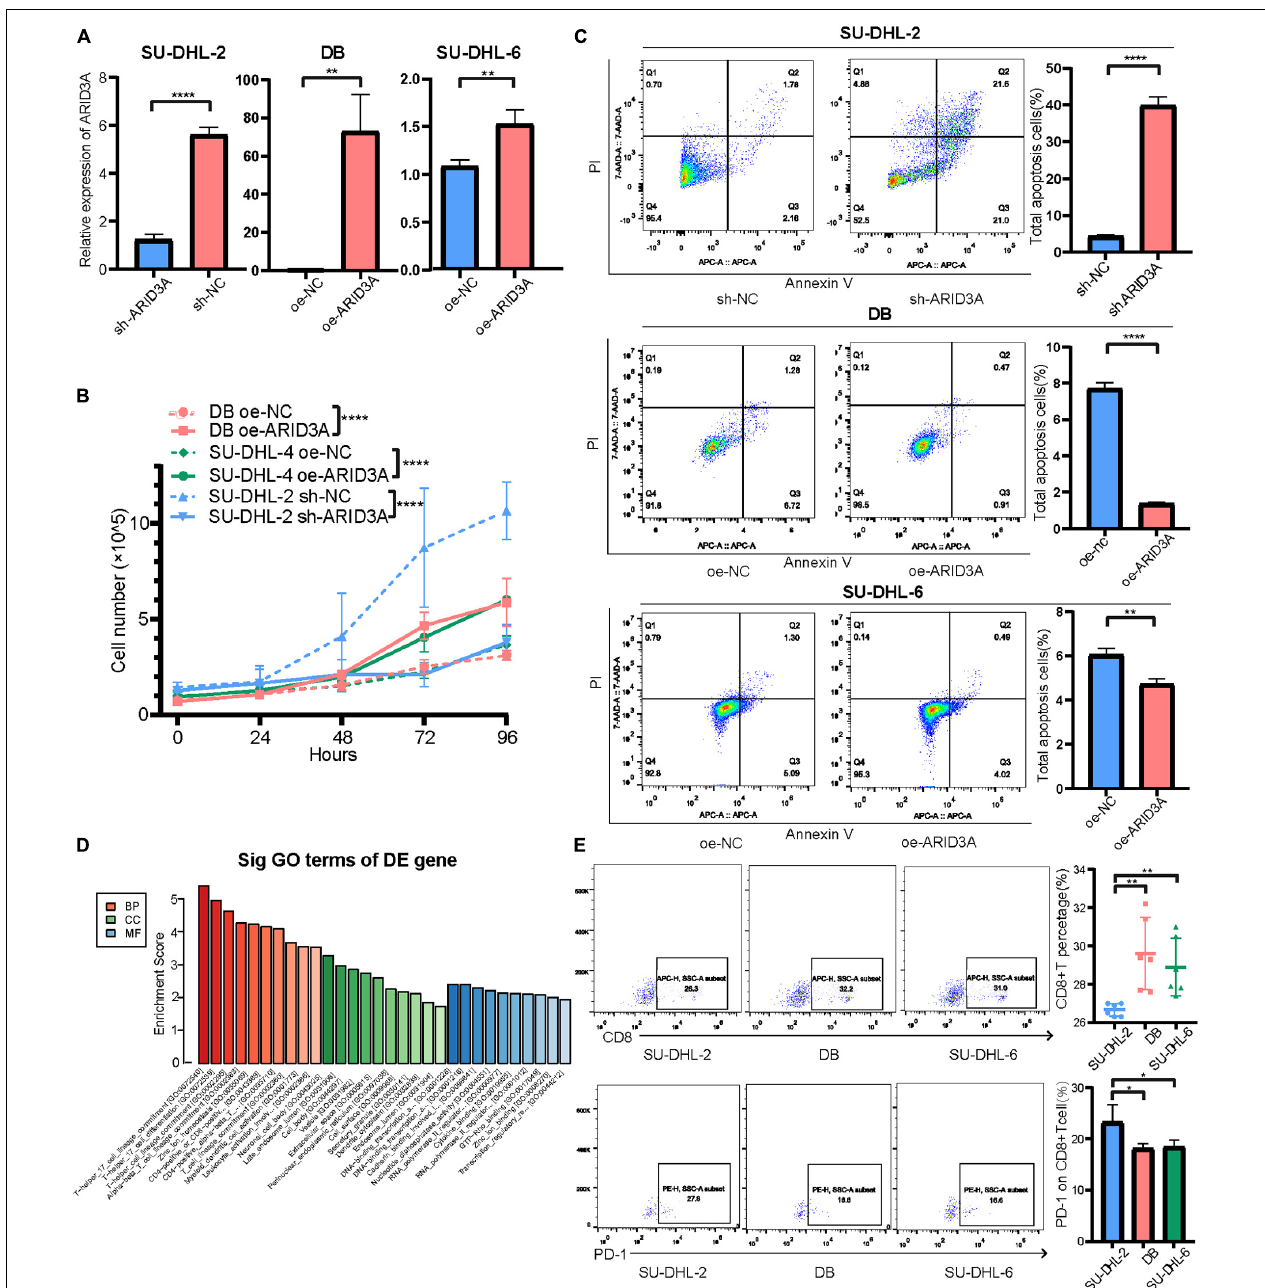
FIGURE 4 | (A) Inhibition and overexpression of ARID3A in DLBCL cells was confirmed with RT-qPCR assays. (B) Cell proliferation ability of ARID3A knockdown SU-DHL-2 cells, ARID3A overexpressing DB and SU-DHL6 cells, and negative control cells was counted using trypan blue exclusion staining. (C) Cell apoptosis assays showing the effect of ARID3A knockdown on SU-DHL-2 cells and ARID3A overexpression on DB and SU-DHL-6 cell apoptosis. (D) Differentially intersected genes were subjected to GO term enrichment analyses. (E) CD8 + T cell percentage and the surface PD-1 expression was determined using flow cytometry analysis when co-cultured with DB and SU-DHL-2 cells and transfected cells. All data represented mean ± SD from three independent experiments. * P < 0.05, ** P < 0.01; **** P <